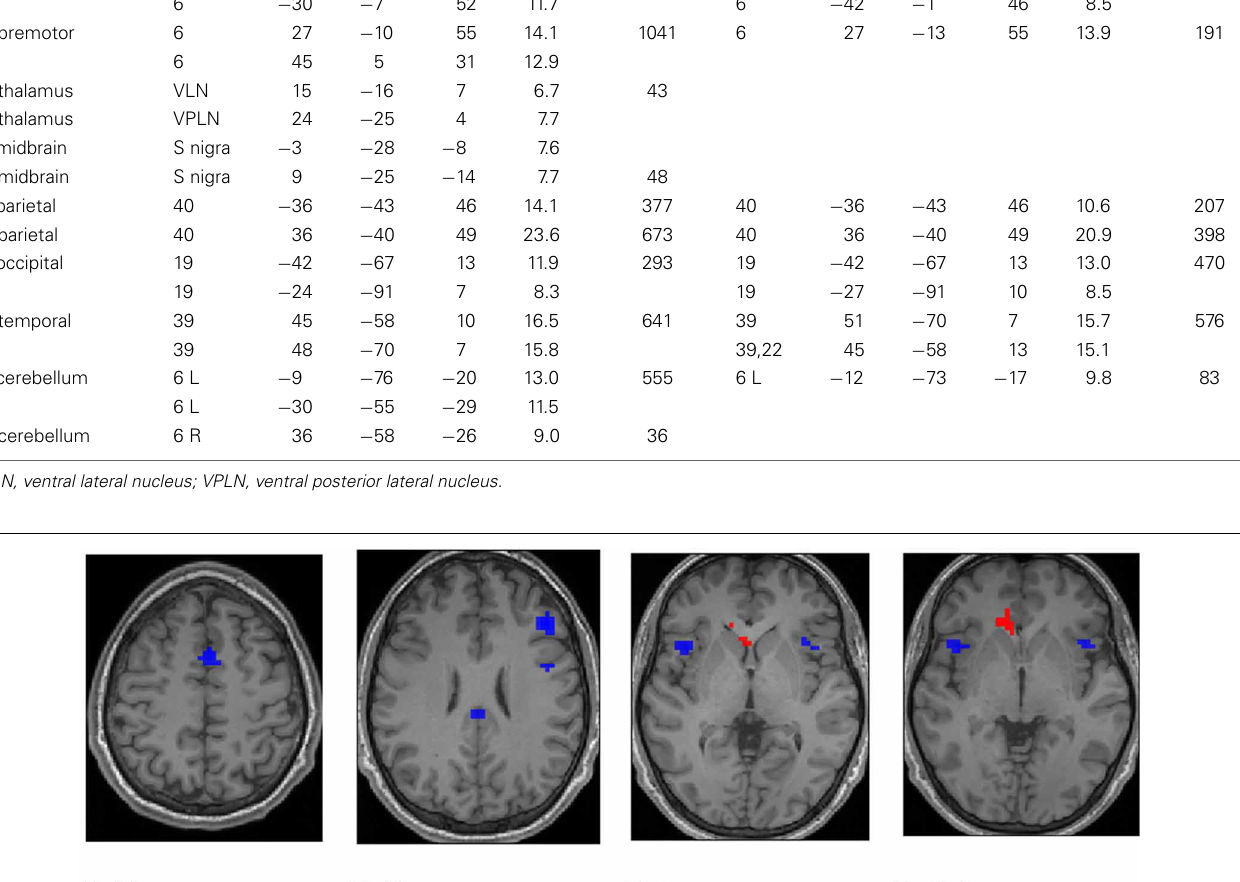
frontal, z = 28; dorsolateral prefrontal cortex and posterior cingulate cortex, z = 1; blue: left and right anterior insula, red: left caudate nucleus. z = − 2 . 4; blue: left and right anterior insula; red: anterior cingulate cortex. Data are combined across participant groups and occlusion